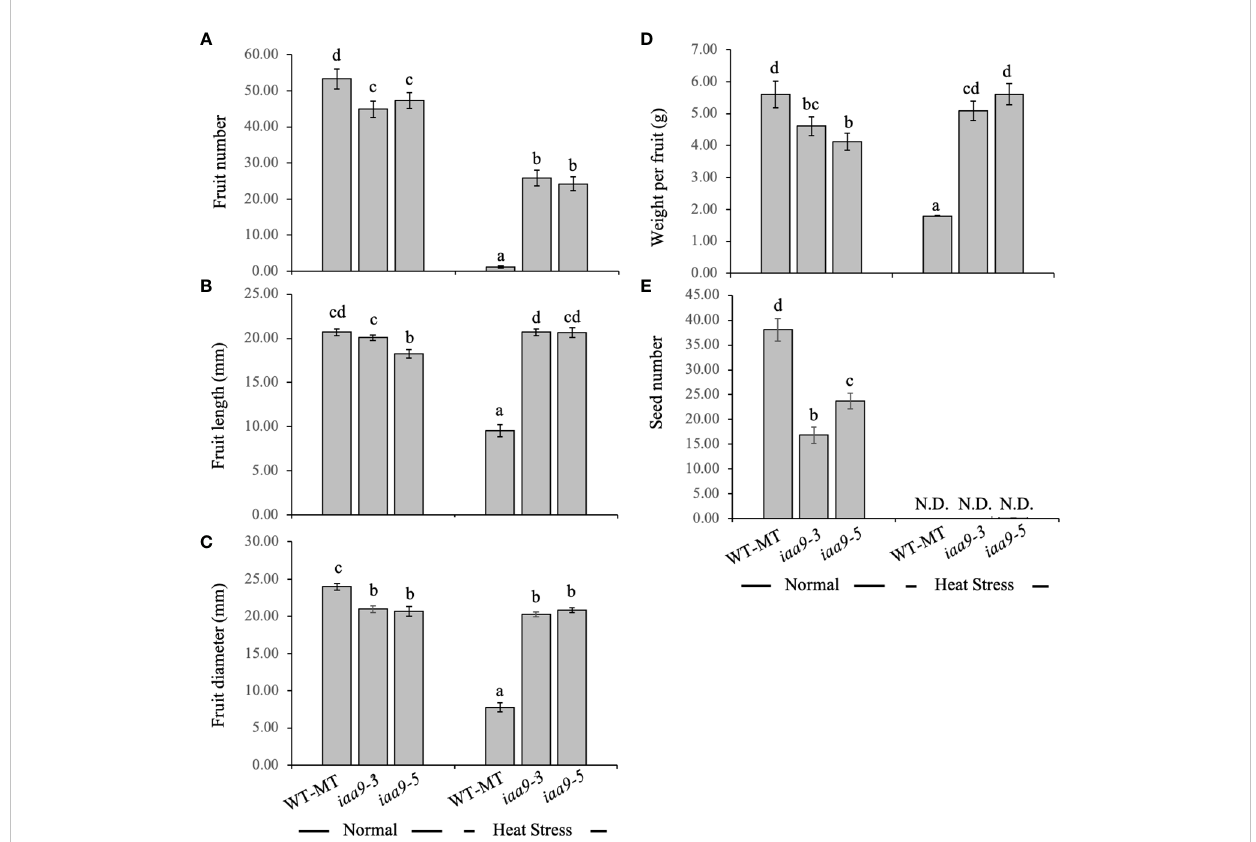
FIGURE 6 (A) Fruit number, (B) fruit length, (C) fruit diameter, (D) individual fruit weight, and (E) seed number of WT-MT, iaa9-3 and iaa9-5 under two